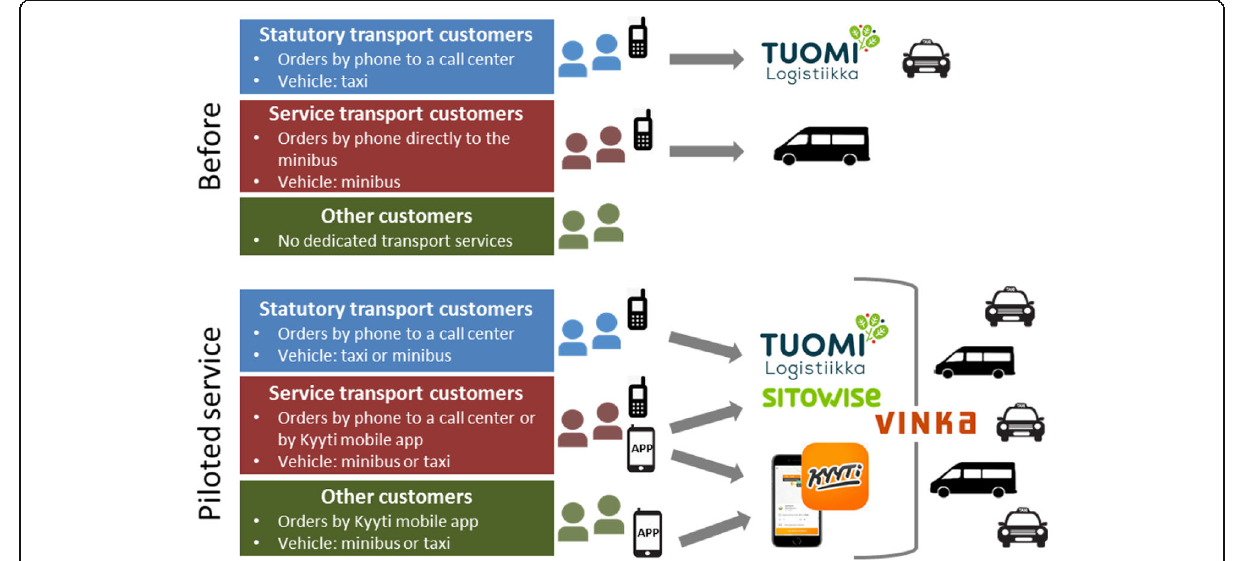
Fig. 4 Transport services for different user groups before and during the Case 2 pilot